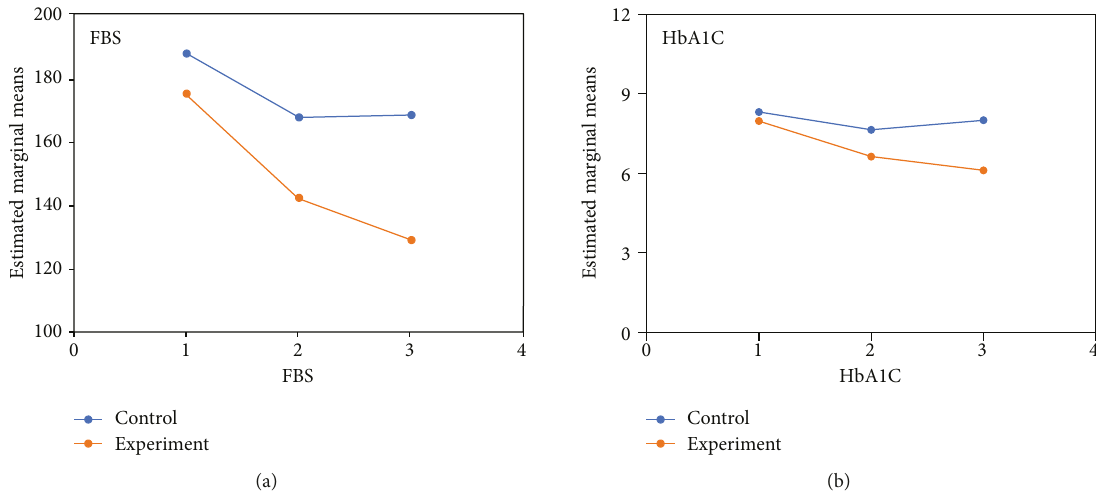
Figure 1: The trajectory of changes in glycemic control measures (FBS and HbA1c) in the intervention and control groups during the time of study (1 =baseline, 2=8weeks, 3